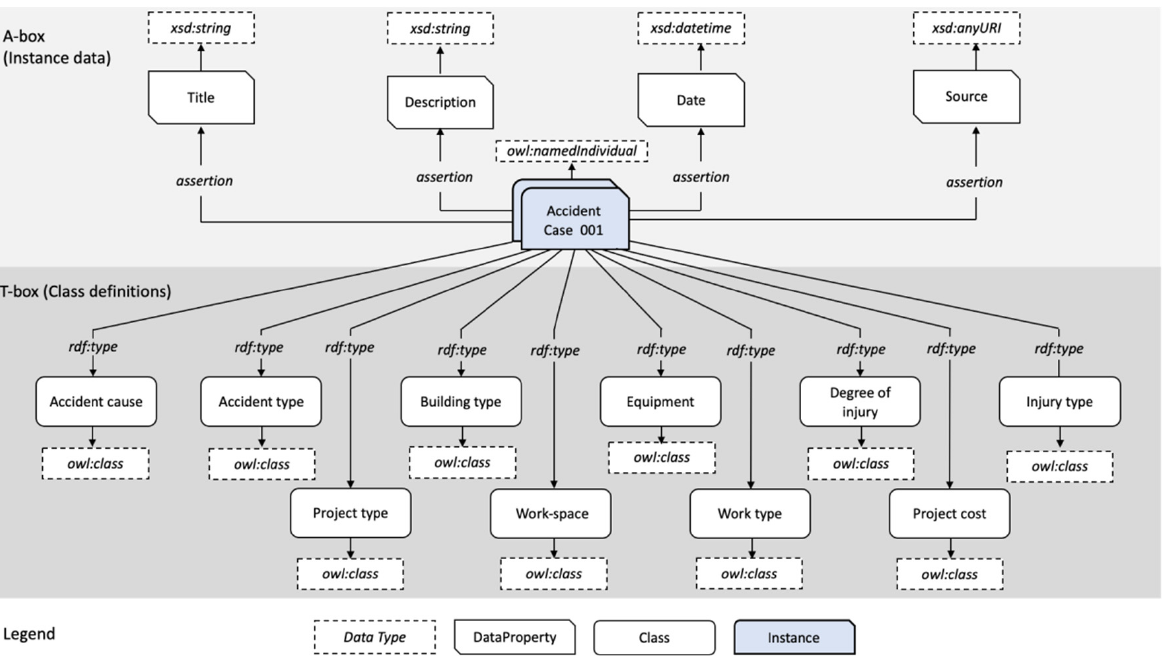
Figure 4. Ontology schema for accident data representations.